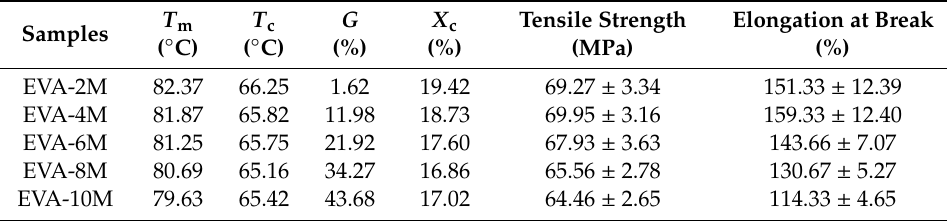
Table 1. Physical and mechanical properties of different EVA fiber.